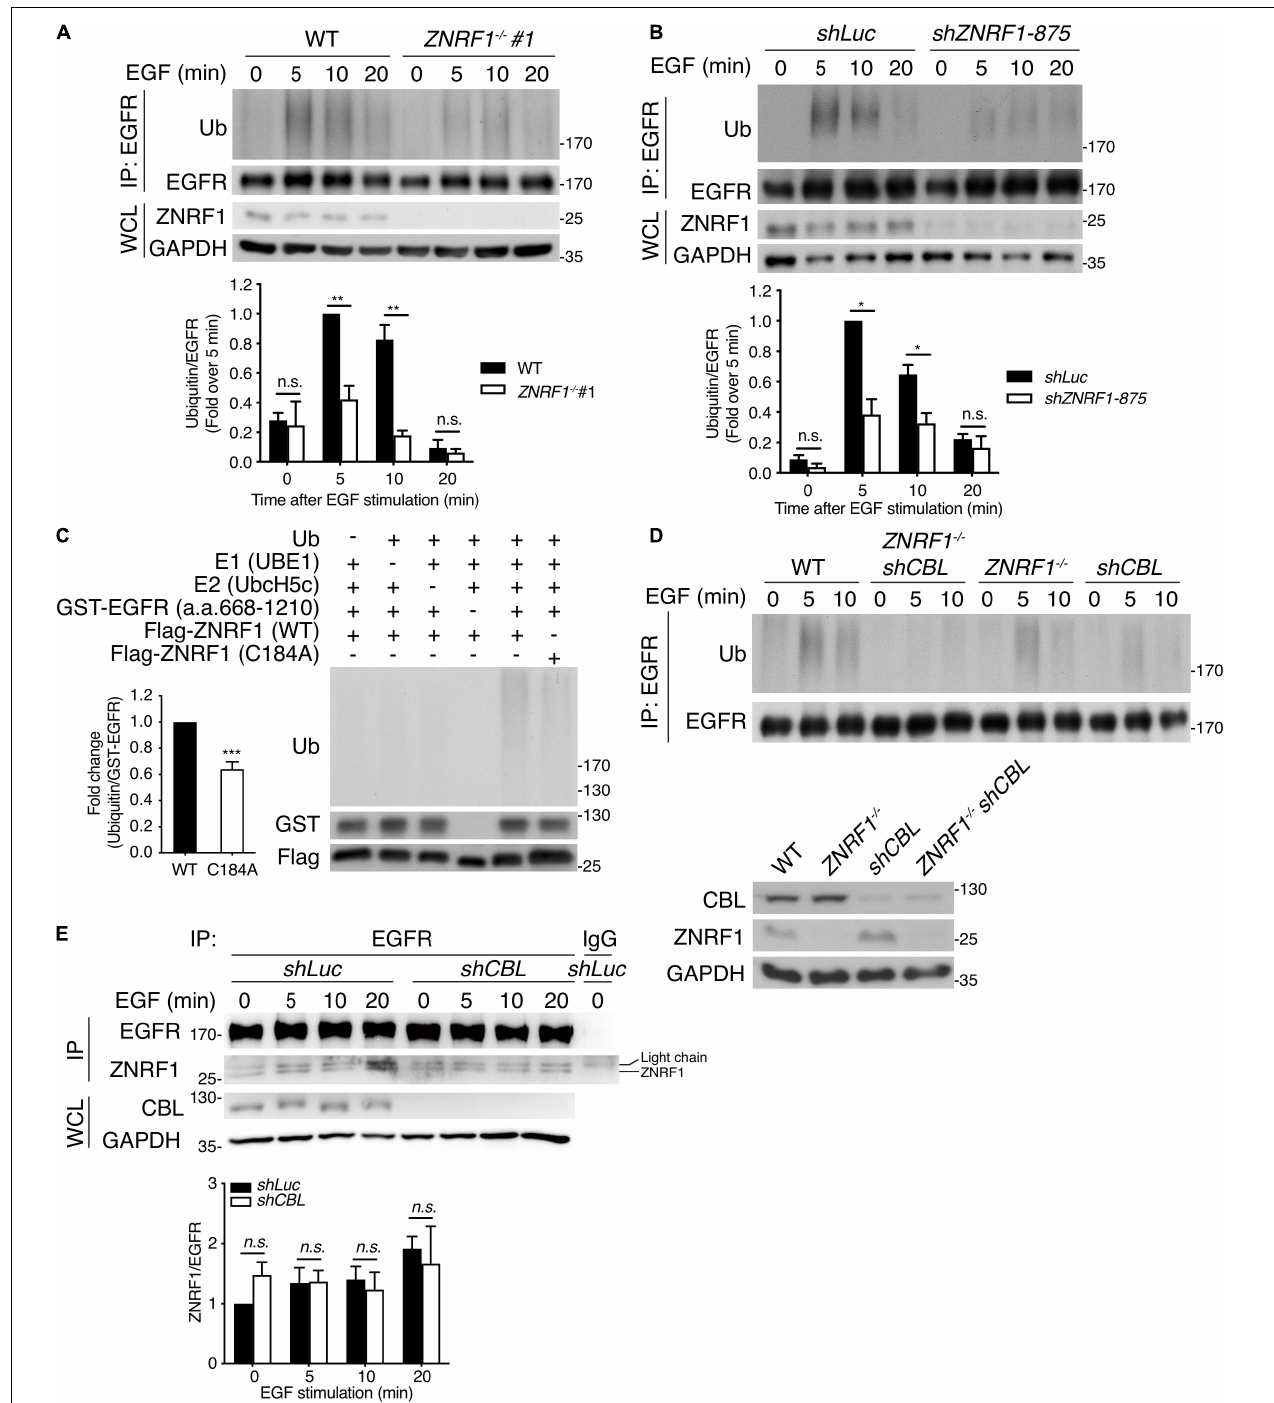
FIGURE 5 | ZNRF1 mediates EGF-induced EGFR ubiquitination. (A) Wild type (WT) and ZNRF1 − / − (B) shLuc and shZNRF1 -expressing A549 cells were serum-starved overnight and stimulated with 100 ng/mL EGF for the indicated times. EGFR was immunoprecipitated with anti-EGFR antibody, followed by immunoblotting with anti-ubiquitin and anti-EGFR antibodies. (C) In vitro ubiquitination assays were conducted with bacterially expressed Flag-tagged WT ZNRF1 or ZNRF1(C184A) mutant together with recombinant ubiquitin, E1, E2 (UbcH5c), and GST-tagged EGFR (a.a. 668–1210) as indicated. The reaction mixtures were subjected to immunoblotting using antibodies against ubiquitin, GST, and Flag antibodies. (D,E) Wild type, ZNRF1 − / − , shCBL, or shCBL -expressing ZNRF1 − / − A549 cells (D) , or A549 cells expressing shLuc or shCBL shRNA (E) were serum-starved overnight and stimulated with 100 ng/mL EGF for the indicated times. EGFR was immunoprecipitated and the immunocomplexes as well as WCL were subjected to immunoblotting with the indicated antibodies. Quantification of immunoblotting analysis data of three independent experiments are shown in the lower panels. Results are presented as averages ± SEM. n.s., no significant; * P < 0.05, ** P < 0.01, *** P < 0.001 (Student’s t -test).